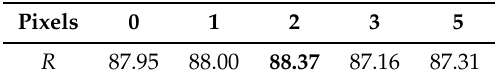
Table 3. Influence of edge exclusion width for texture segmentation (best score in